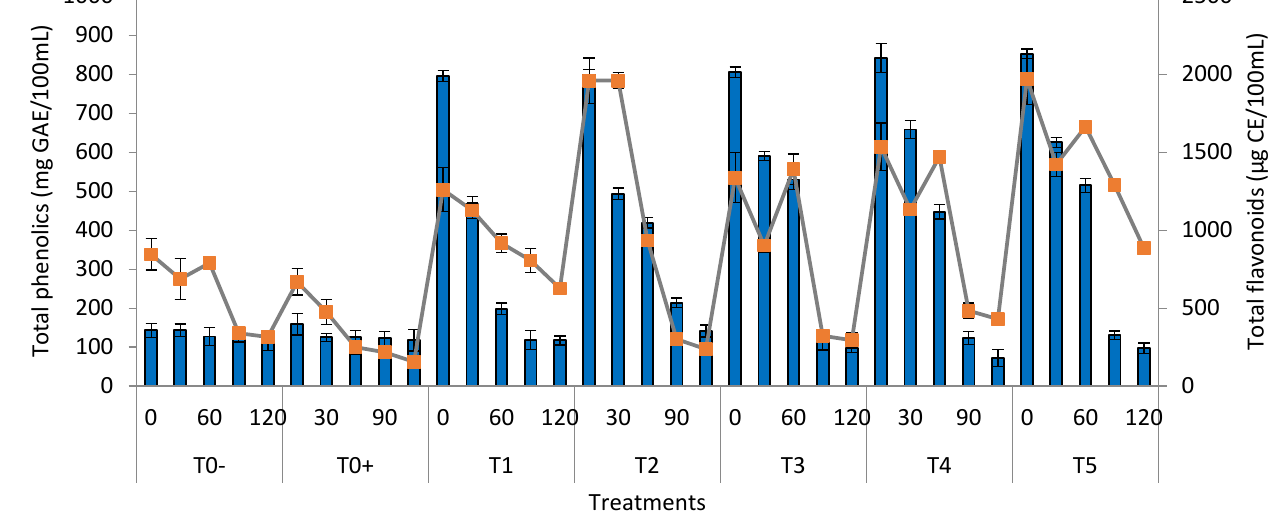
Figure 1. Phytochemicals (total phenolics and flavonoids) of watermelon juice (T 0 − = control (wa- termelon juice with no preservative and treatment); T 0+ = control (watermelon juice preserved with KMS); T 1 = 2 min ultrasound & 2 min microwave; T 2 = 4 min ultrasound & 1 min 50 s microwave; T 3 = 6 min ultrasound & 1 min 50 s microwave; T 4 = 8 min ultrasound & 1 min 50 s microwave; T 5 = 10 min ultrasound & 1 min 50 s) during storage.